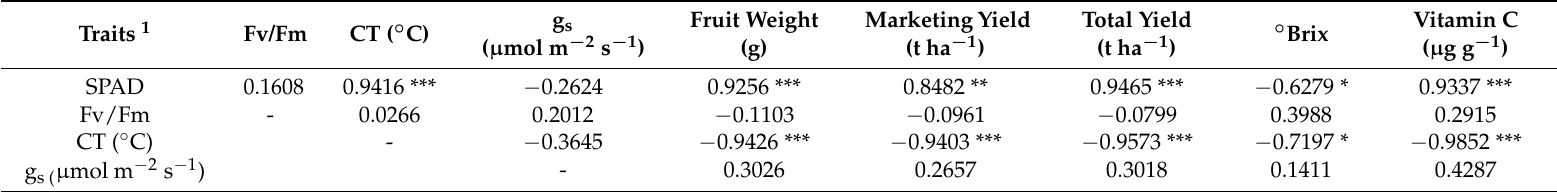
Table 4. Correlation coefficients (r) and significance levels between physiological traits and yield and quality of tomato under deficit irrigation (DI), n = 8.